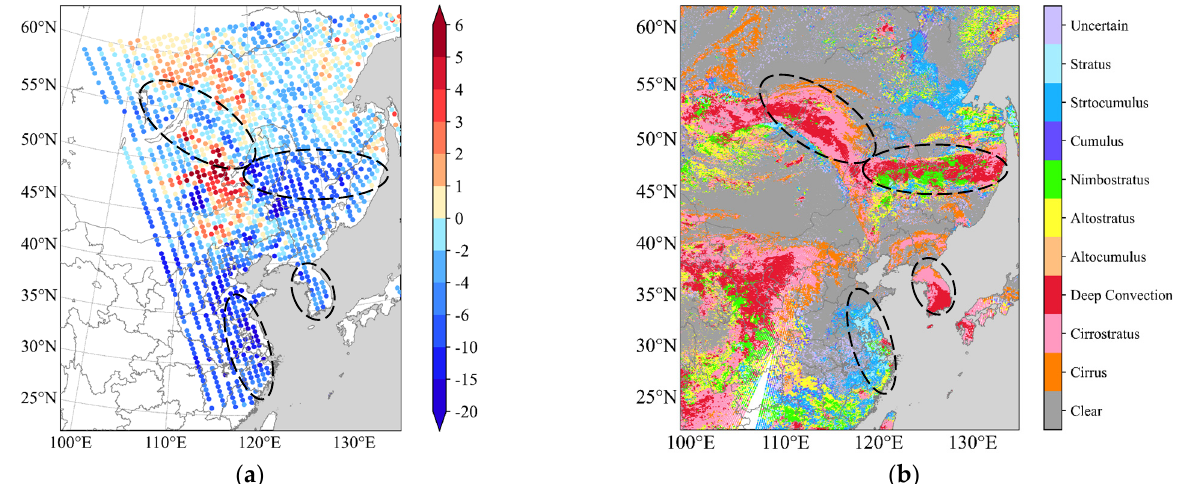
Figure 2. Spatial distribution of ( a ) the O − B of AMSU-A channel 3 (unit: K) and ( b ) MODIS cloud classification products in East Asia at 0600 UTC on 26 June 2019.